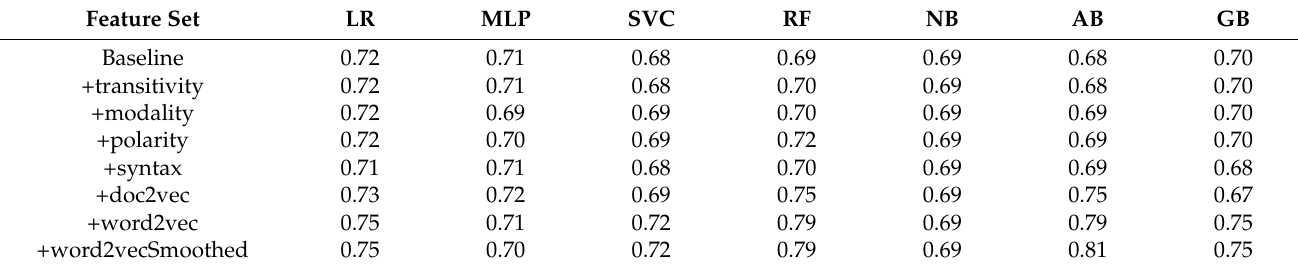
Table 4. Classification of solutions from non-solutions using ML classifiers by 10-fold cross